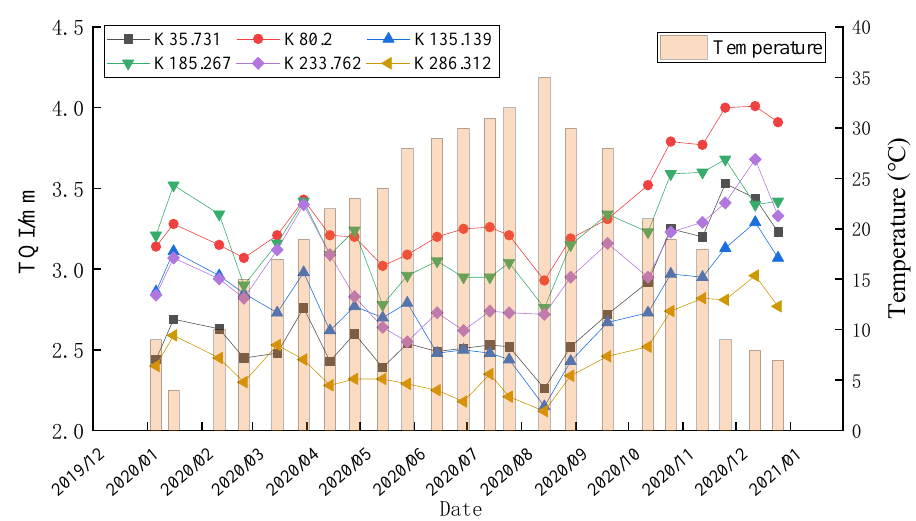
Figure 7. Variation of TQI and temperature with time.